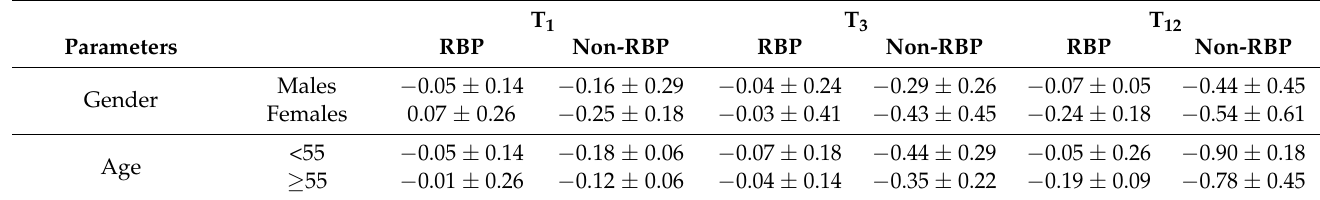
Table 3. Mean ± SD values of the Marginal Bone Level (MBL) at 1, 3 and 12